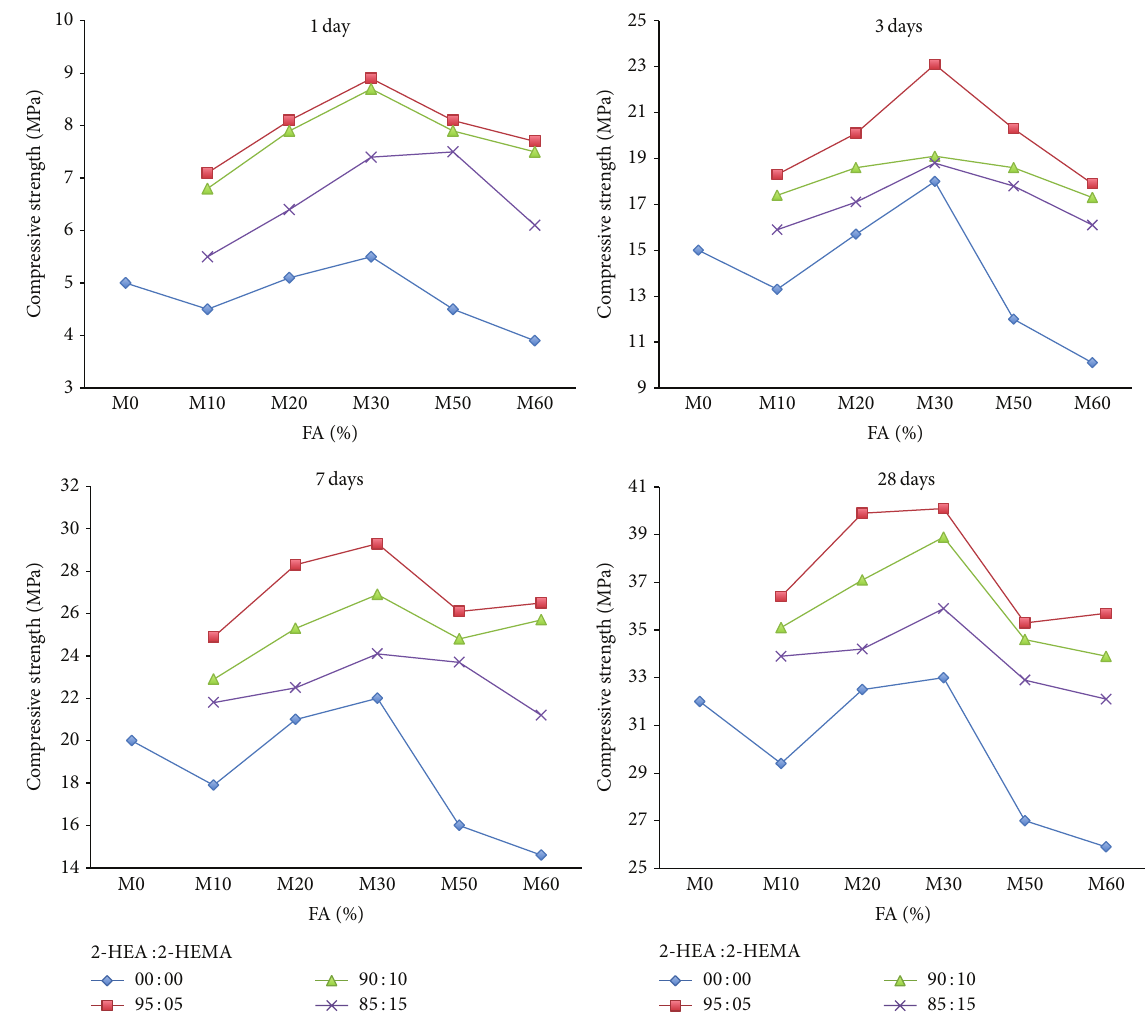
Figure 8: The effect of FA on compressive strength of mortar mixes in presence of latexes.